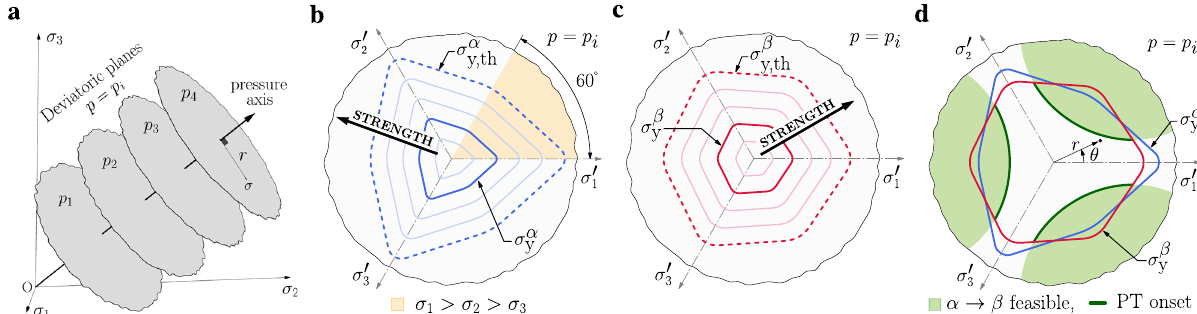
Fig. 1 A schematic of the feasible phase transformation domains in stress-space. a Three dimensional principal stress-space represented by the σ 1 , σ 2 , and σ 3 principal stress axes ( σ 1 = σ 2 = σ 3 is the p -axis, deviatoric planes are perpendicular to this axis). Panels b , c show envelopes outside of which α and β fl ow (yield) on a particular deviatoric plane. The axes σ 0 material is strengthened, the yield envelopes, σ α α → β PTs are feasible (shaded light green). The PT onset boundary is shown in